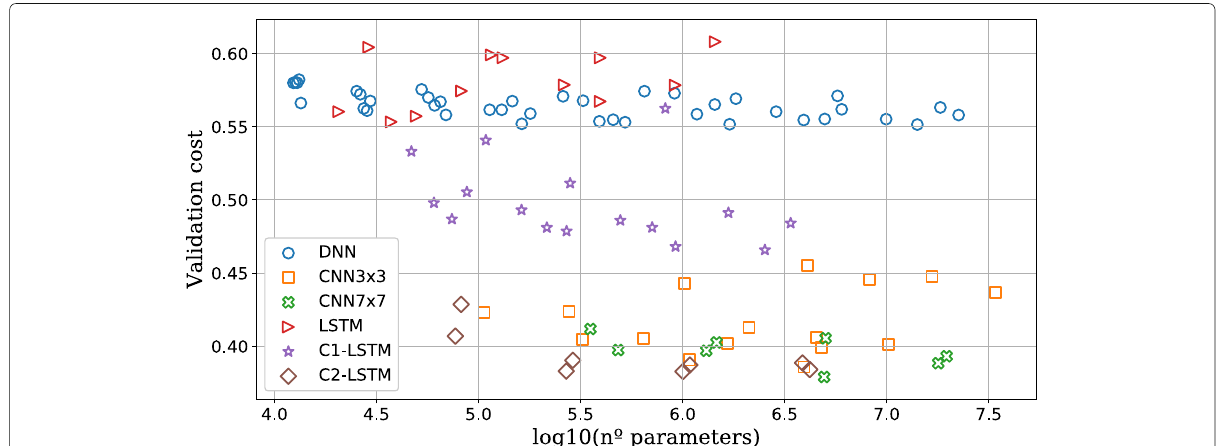
Fig. 6 Music event detection validation cost across the evaluated models. Each point in the scatter plot represents one of the trained networks, and its position along the horizontal and vertical axes indicates the number of parameters (in a logarithmic scale) and the validation cost obtained, respectively